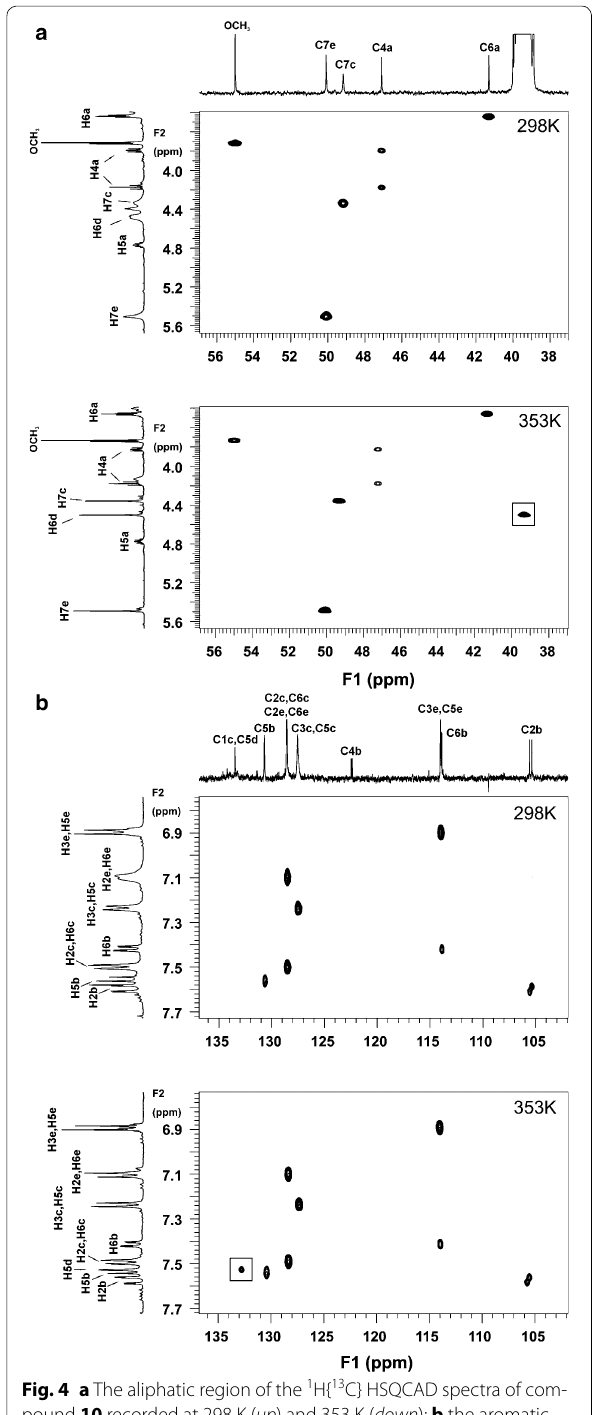
Fig. 4 a The aliphatic region of the 1 H{ 13 C} HSQCAD spectra of com‑ pound 10 recorded at 298 K ( up ) and 353 K ( down ); b the aromatic region of the 1 H{ 13 C} HSQCAD spectra of compound 10 recorded at 298 K ( up ) and 353 K ( down ). Correlation peaks for CH (5d) and CH 2 (6d) groups were observed only in spectrum recorded at 353 K (crosspeak marked in rectangle